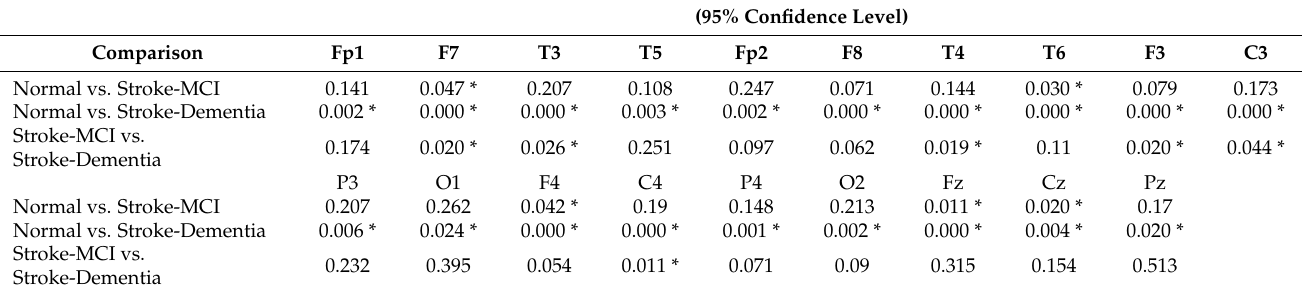
Table 9. The results of post hoc multiple comparison (SpecEn).